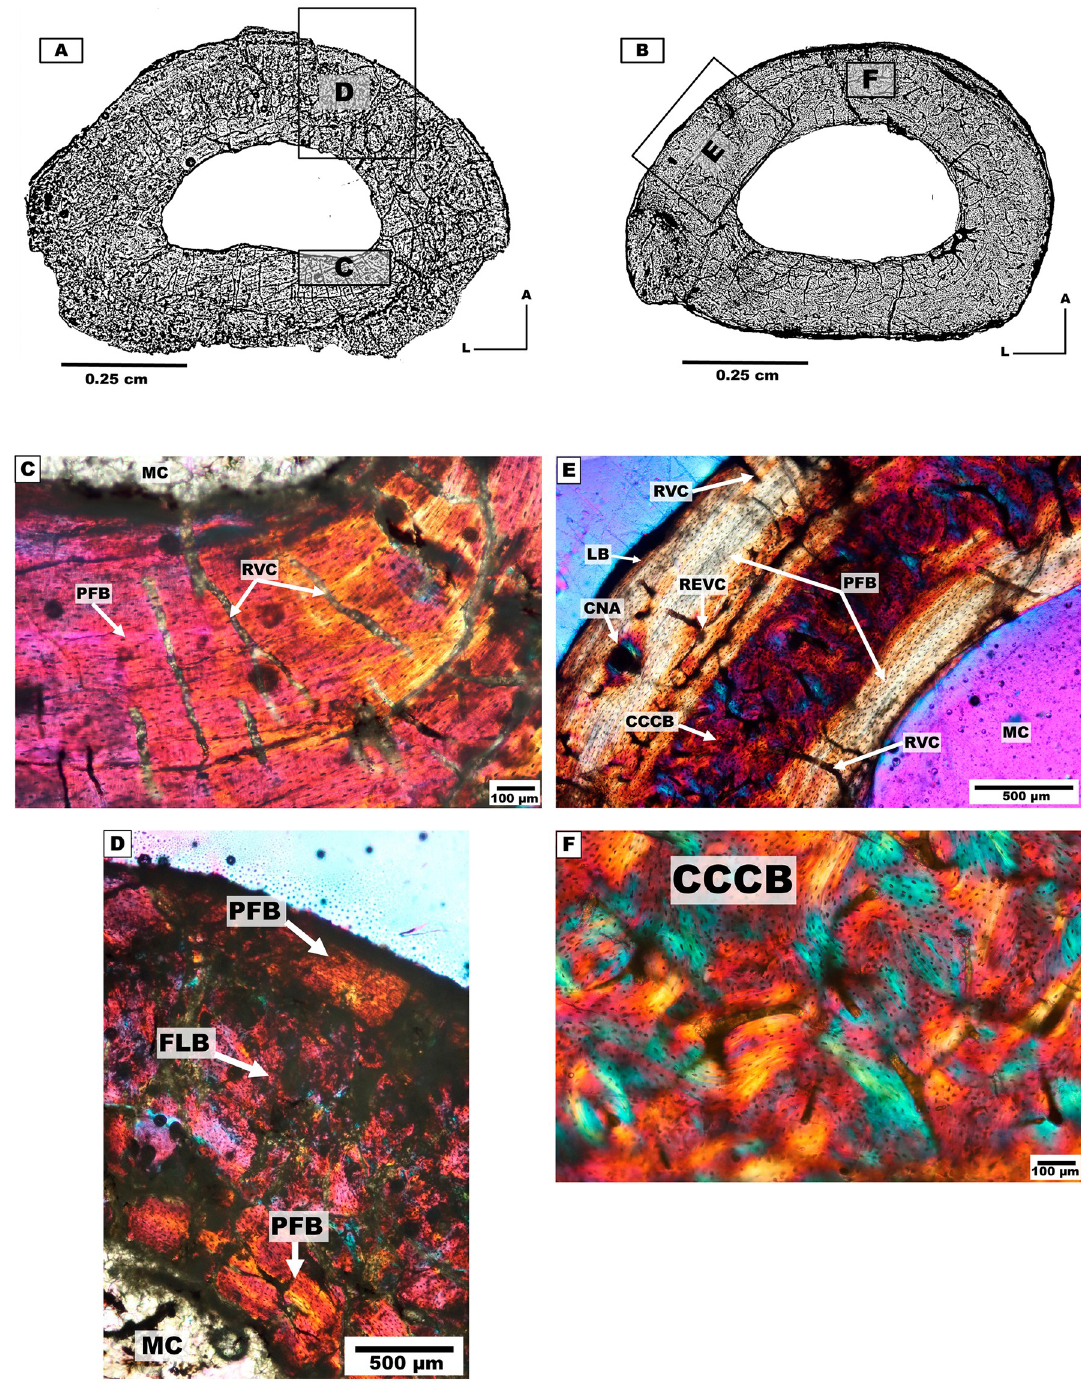
Fig 7. First phalanges cross-sections of the mesotheriine notoungulate Caraguatypotherium munozi from middle Miocene of Caragua, Huaylas formation. (A) First phalange cross-section for individual 1 (GEOUACH.HS.PFI.1); (B) First phalange cross section for individual 2 (GEOUACH.HS.PFD.1); (C) Endocortical region presence PFV and RVC can open to the medullary cavity (GEOUACH.HS.PFI.1); (D) FLB in the intracortical region and PFB in the pericortical region (GEOUACH.HS.PFI.1); (E) Diversity of structures in sections, PFB with RVC in the endocortical region, CCCB in the intracortical region, LB and PFB in the pericortical region with presence of RVC and CNA (GEOUACH.HS.PFD.1); (F) CCCB in the intracortical region (GEOUACH.HS.PFD.1). For abbreviations refer to Fig